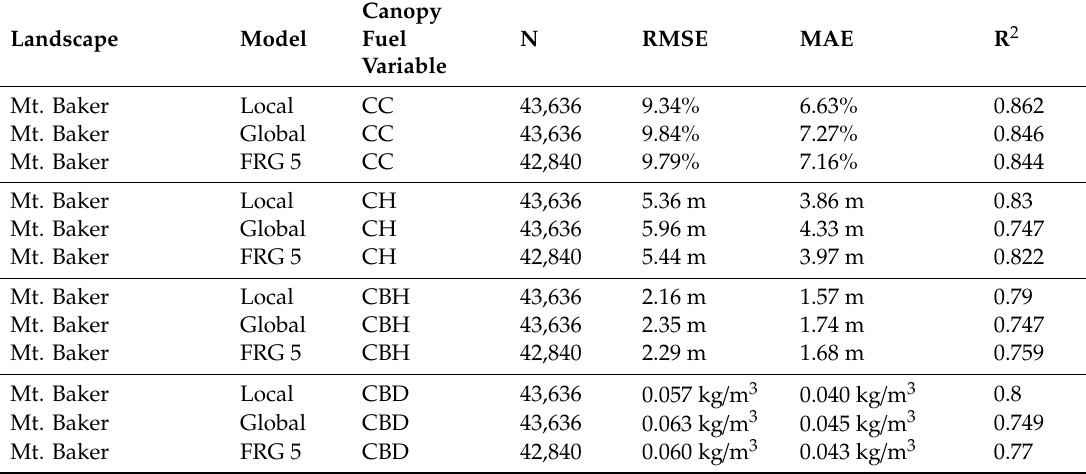
Table A1. Performance assessment of local, global, and fire regime group (FRG) models using training landscapes. In total, 80% of landscape data used for training, 10% for validation, and 10% for testing. N refers to the number of samples used for testing and calculation of performance metrics, which